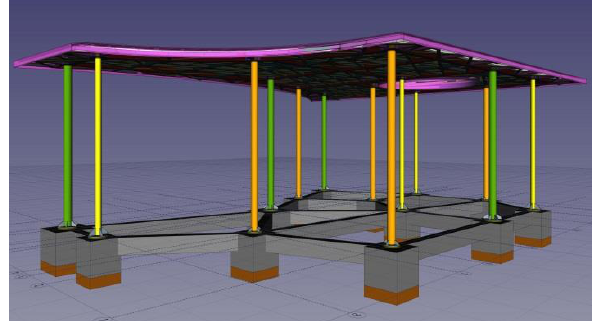
Figure 5. The Freecad BIM Model, a view of a curved